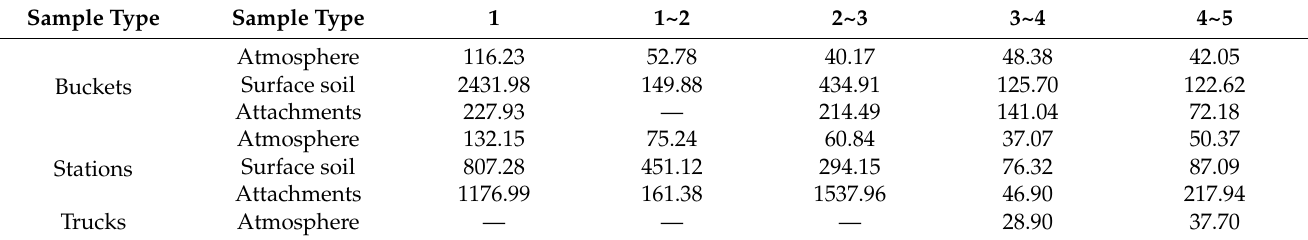
Table 7. Potential ecological risk indexes of the different sample categories.